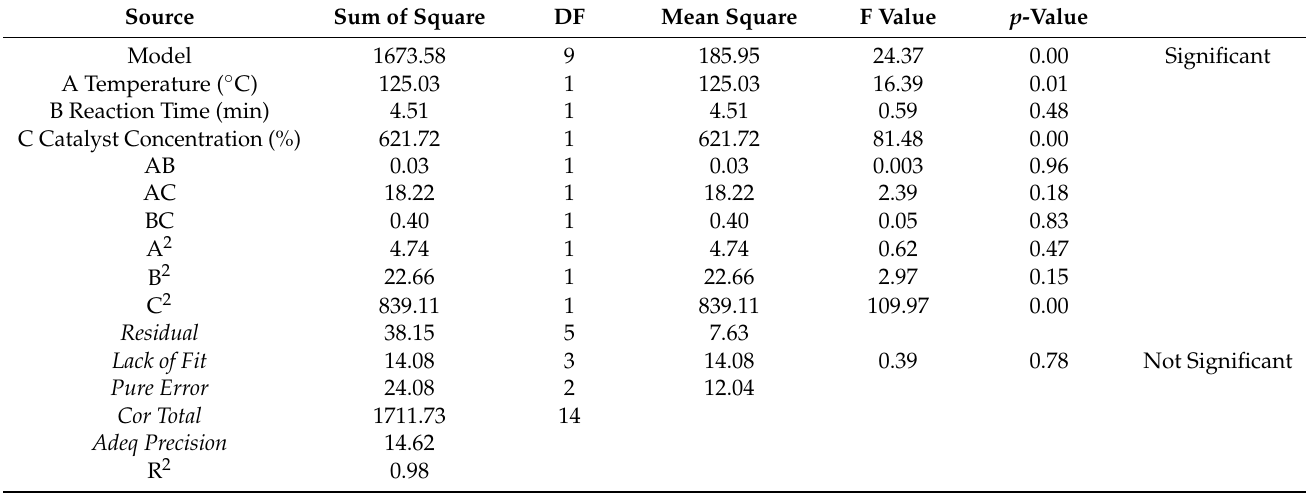
Table 6. Analysis of the Variance and Regression Coefficients of the BBD Quadratic Model to Predict the FFA